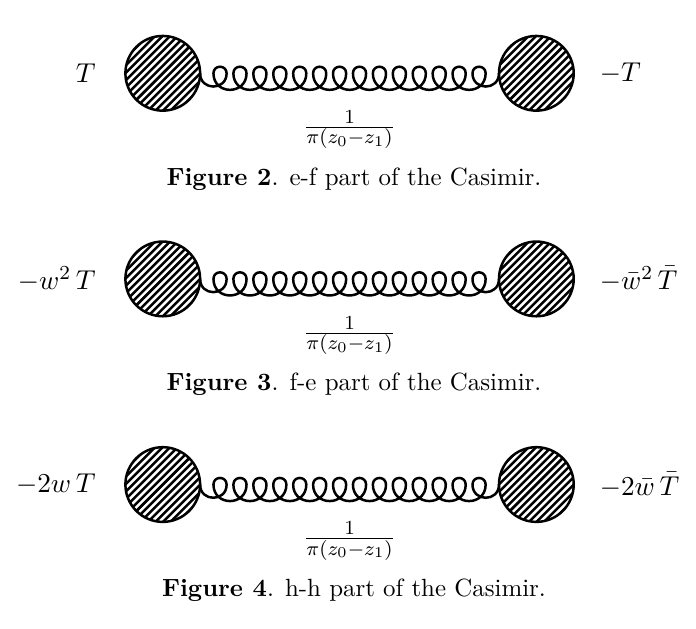
Figure 4 . h-h part of the